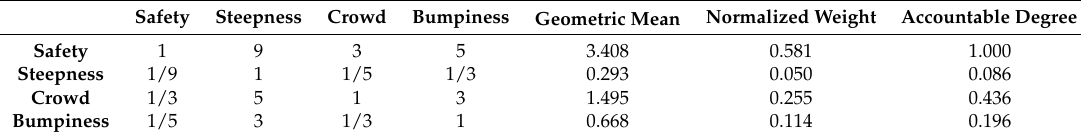
Table 2. Comparison of Evaluation Factors.